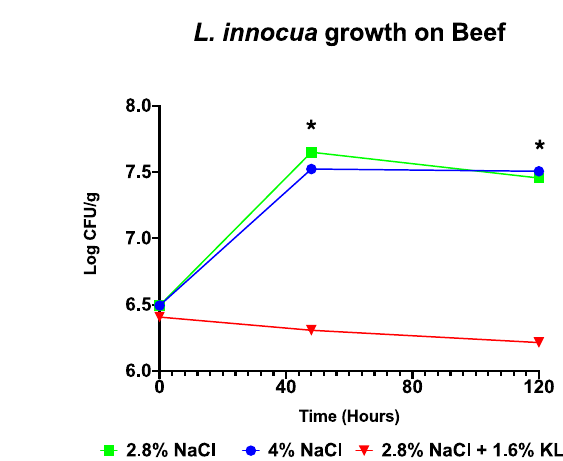
Figure 3. Growth behavior of a four strain L. innocua cocktail under simulated salami ripening conditions in the ( A ) MSB and ( B ) on beef-based models. The low NaCl (2.8%) plus KL (1.6%) combination displayed superior anti Listeria activity compared to the traditional salami recipe of high salt (4% NaCl) concentration. Data are mean log CFU counts from three biological replicates. * Indicates significant difference between treatments at that time point ( p < 0.05 based on one-way ANOVA and Tukey post-hoc test pairwise comparison).